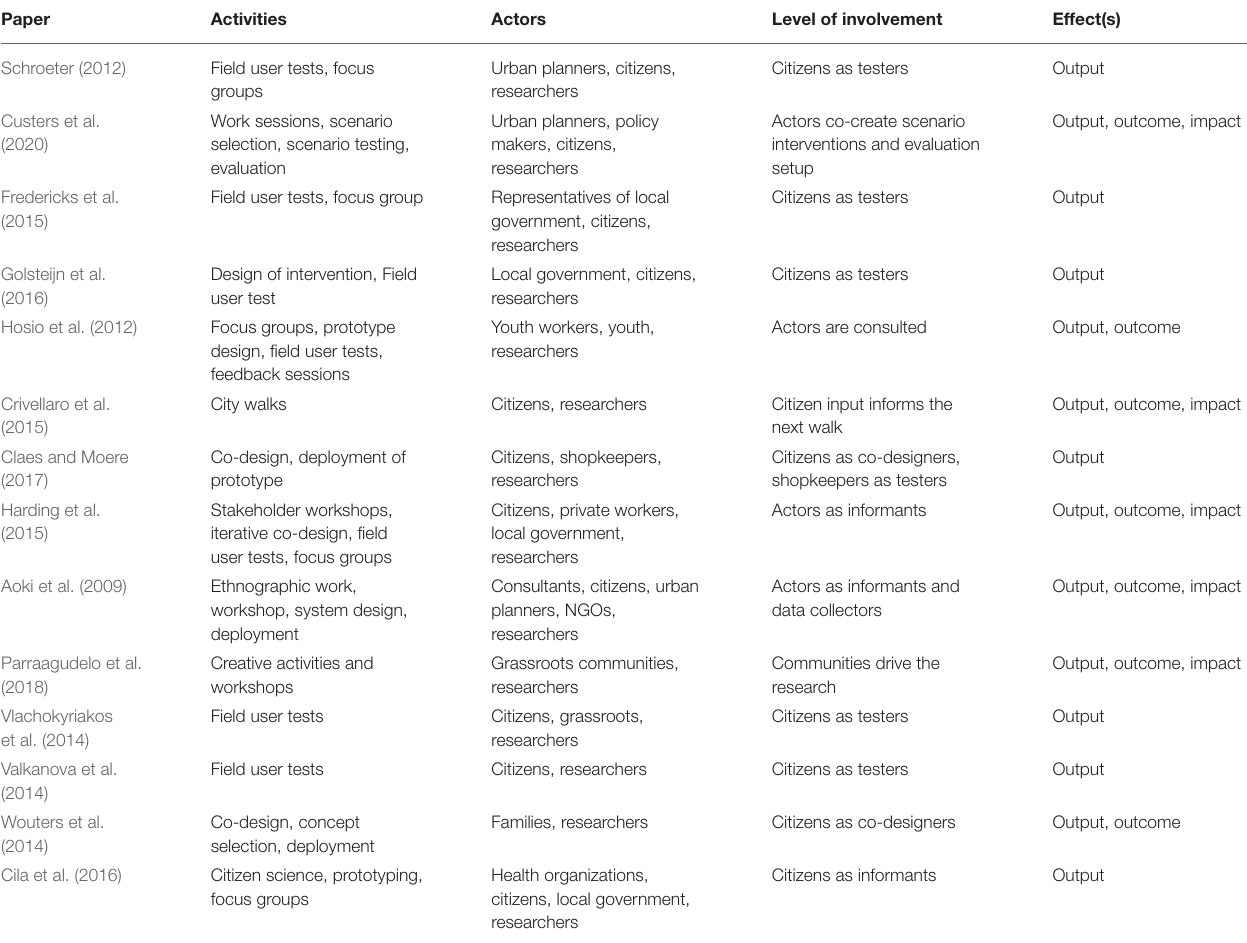
TABLE 1 | Fourteen research projects are analyzed to understand how stakeholders are involved to jointly explore